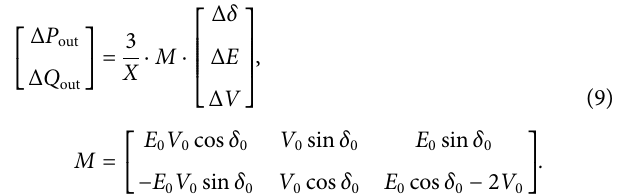
state operating point.